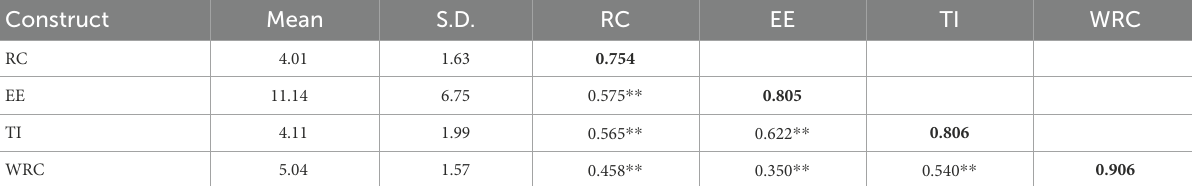
TABLE 3 Descriptive statistics, correlations, and square roots of AVE